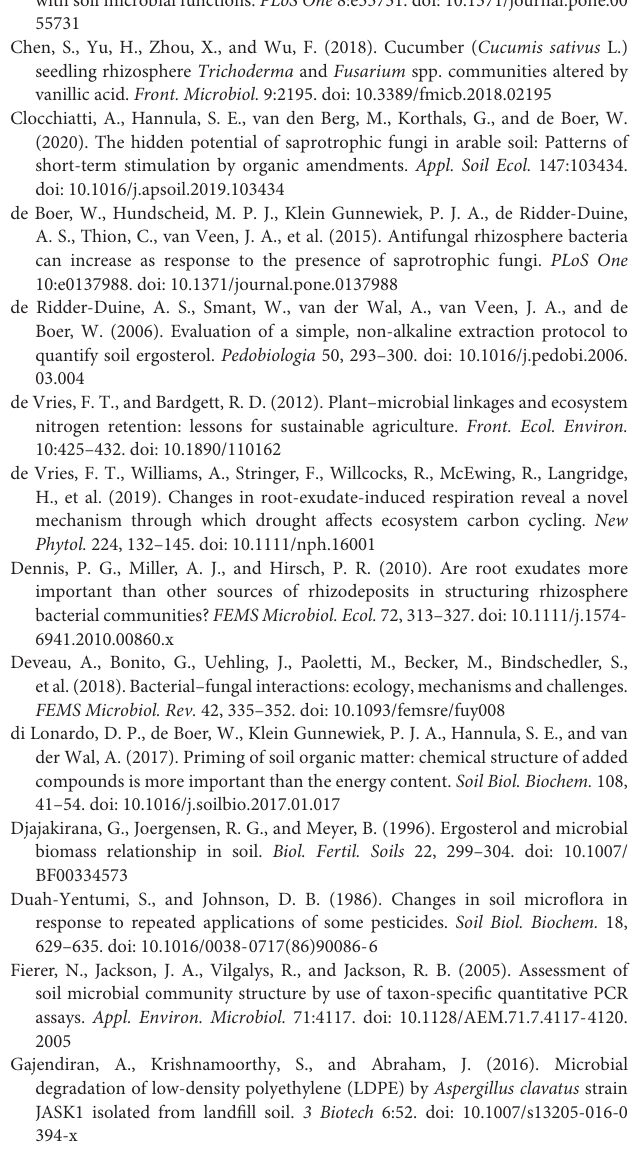
(soil/sand), and presence or absence of primary metabolites (PM) (Exp. 1). df .: degrees of freedon, SS : sum of squares, MS : mean sum of squares. Supplementary Table 2 | Summary of ANOVA results on ergosterol as a function of the Arabidopsis line ( A.t. line) and developmental stage (dev. stage) (Exp. 2), shown for ergosterol in the rhizosphere (A) and for the ergosterol increase in the rhizosphere from its concentration in the bulk soil (B) . df : degrees of freedom, SS : sum of squares, MS : mean sum of squares. Supplementary Table 3 | Summary of permutational analysis of multivariate variance (PERMANOVA) applied to fungal (A) and bacterial (B) community data of the arable soil layer in rhizosphere simulation microcosms using Bray-Curtis distances. The PERMANOVA was applied for the total dataset for partitioning the variance according to two factors (type of phenolic acid x presence of additional primary metabolites, PM). The effect of type of phenolic acid was also tested alone on two subsets of data (Phenolic acid with/without PM), as these had a better homogeneity of multivariate variance. df : degrees of freedom, SS : sum of squares MS : mean sum of squares, p values based on 999